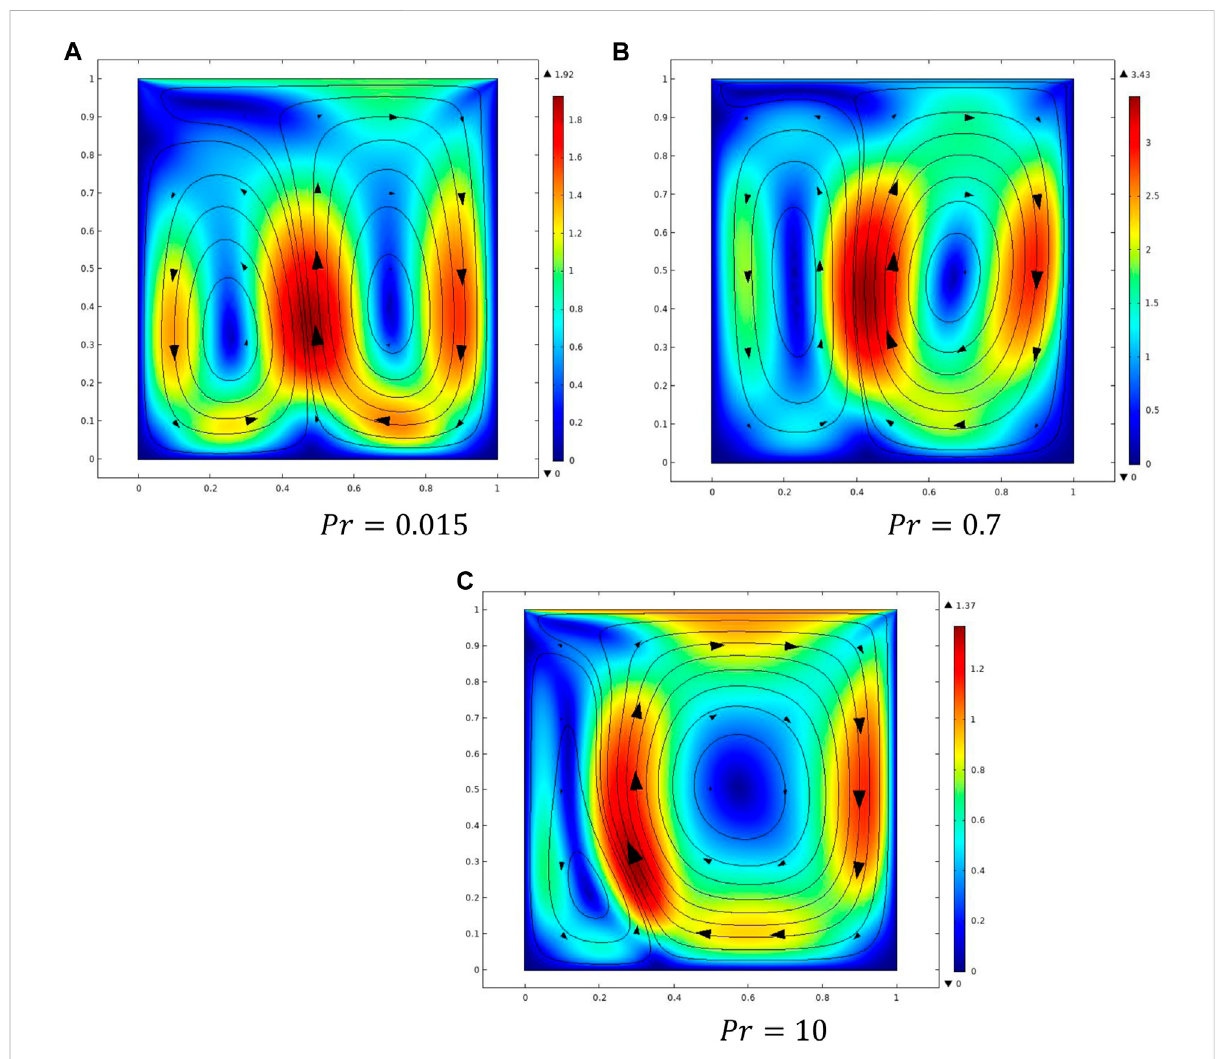
FIGURE 15 In fl uence of Pr on streamlines for the non-uniform heating case: (A) Pr (cid:1) 0 . 015, (B) Pr (cid:1) 0 . 7, and (C) Pr (cid:1)